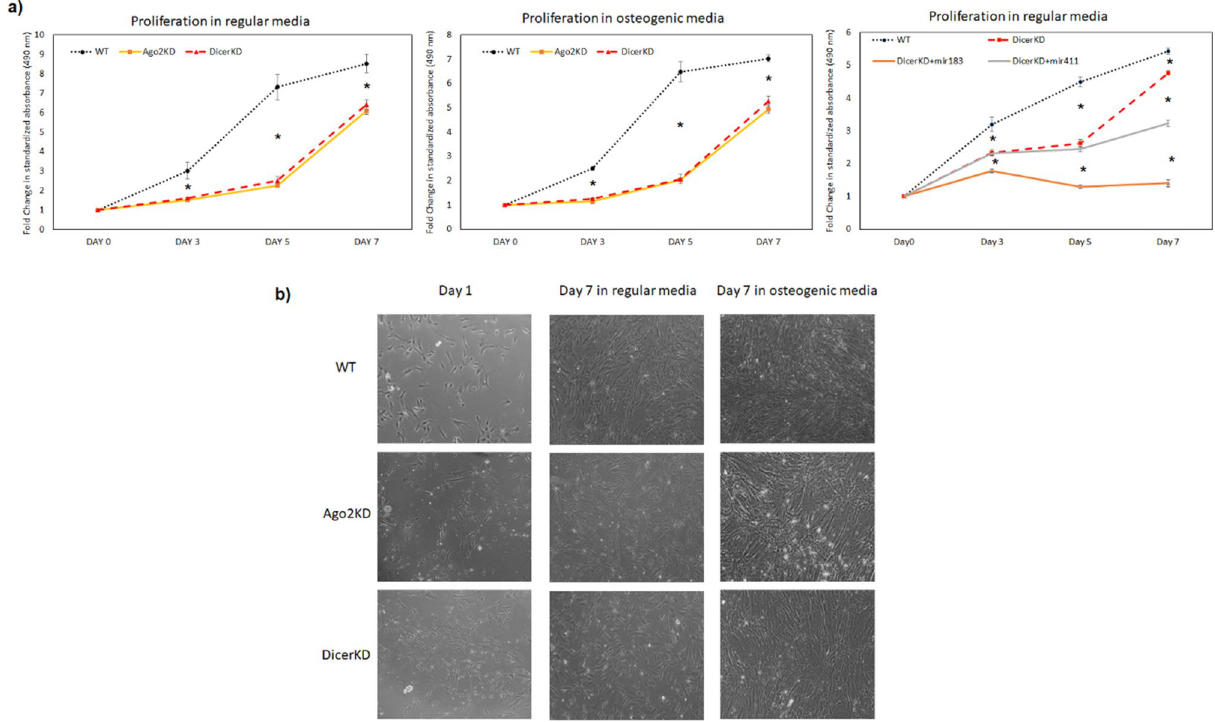
Figure 2. Proliferation experiments. ( a ) Proliferation of WT, DicerKD and AGO2KD hMSCs in regular growth medium and osteogenic medium was assessed using a colorimetric method. The graphs demonstrate standardized fold change in absorbance at 490 nm compared to day 1 in each cell type. ( b ) Morphology of WT, AGO2KD and DicerKD hMSCs at day 1 and 7 after growth in regular and osteogenic medium. All three cell types showed similar morphology under microscopic observation. *Denotes to statistically significant difference ( P < 0.01) as tested with one-way ANOVA and Tukey’s post-hoc